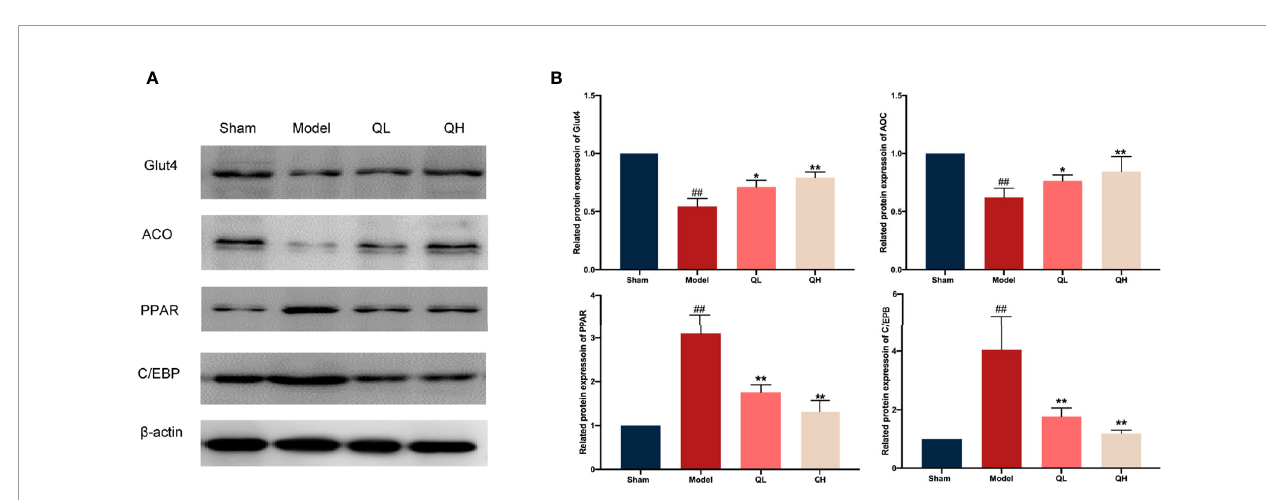
FIGURE 8 | Changes in lipid and glucose metabolism in mice that underwent orchiectomy after quercetin treatment. (A) Expression of lipid and glucose metabolism proteins in the liver, including Glut4, ACO, PPAR, and C/EBP. (B) Glut4, ACO, PPAR, and C/EBP were semi-quanti fi ed by Image J software ## p< 0.01 vs. sham group; * p< 0.05, ** p< 0.01 vs. model